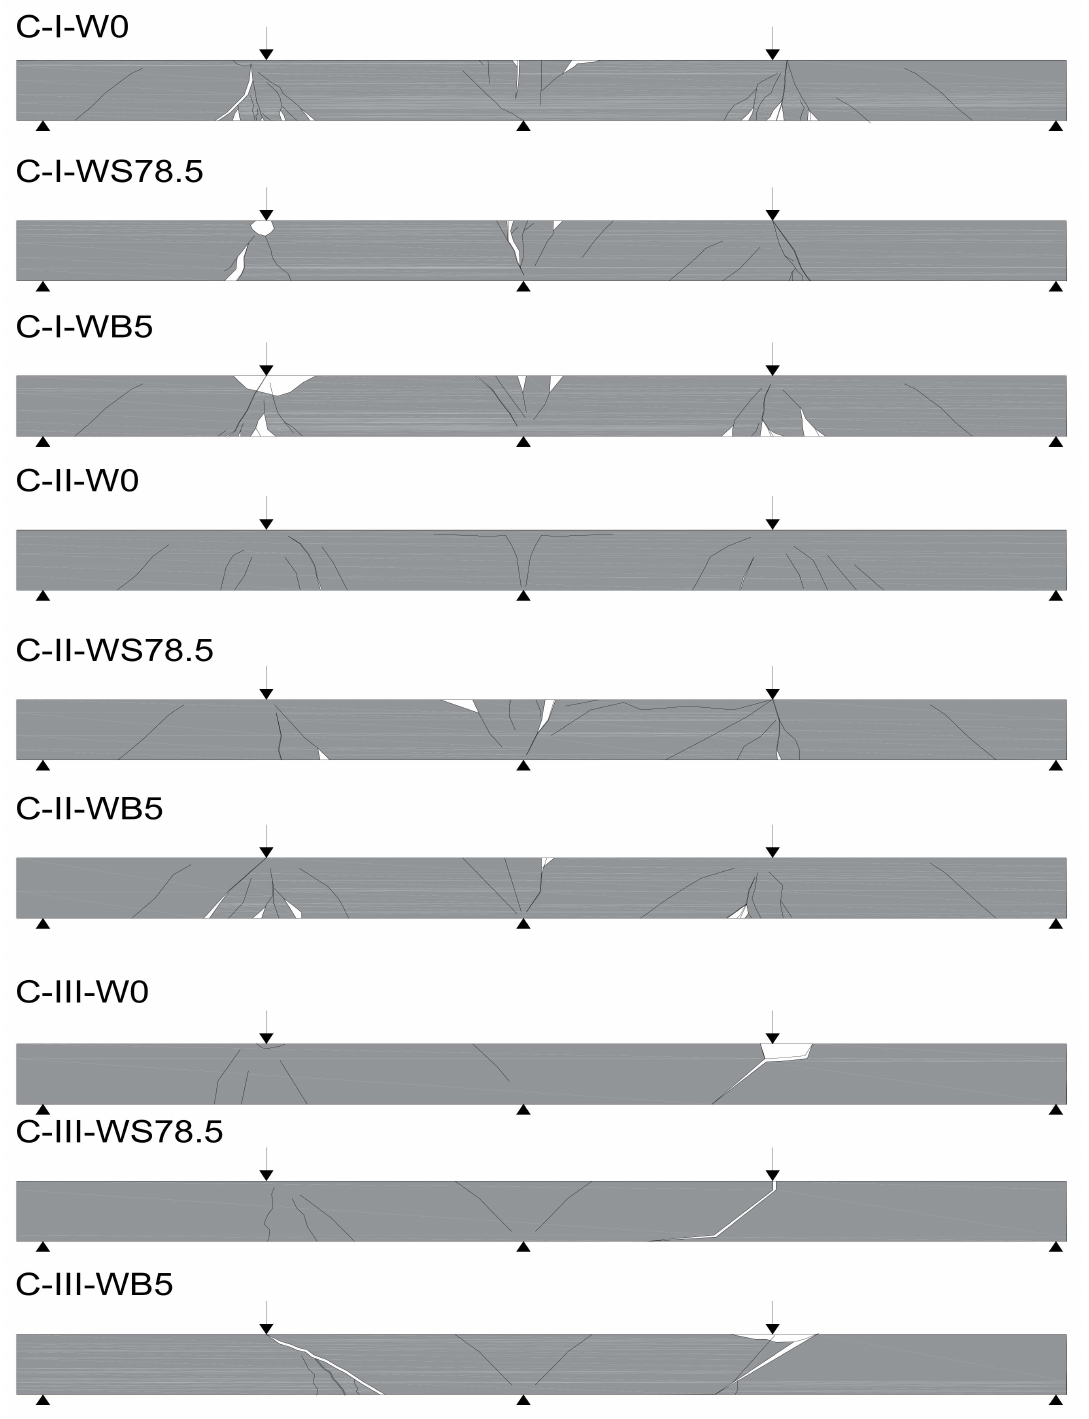
Figure 7. Crack development in tested